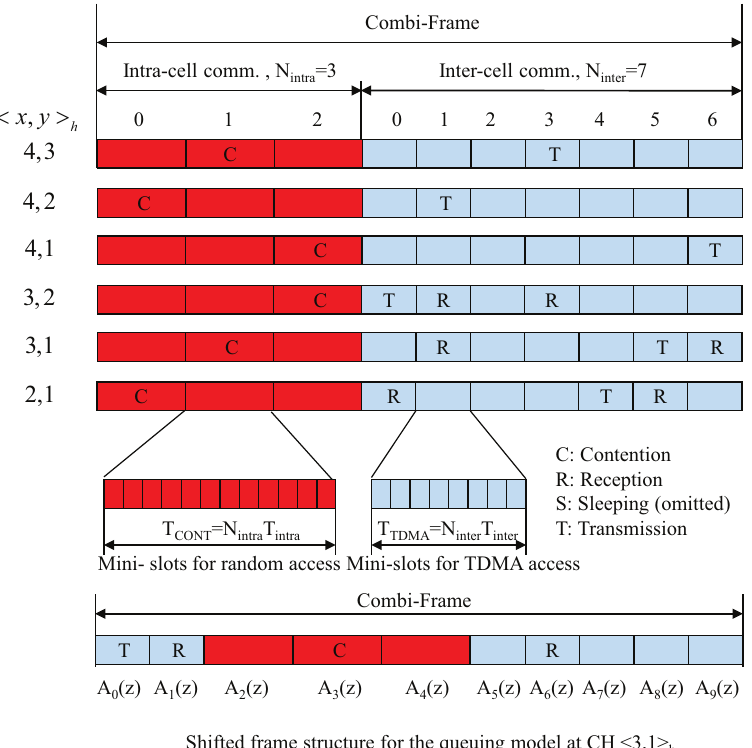
Figure 5. The role of A i ( z ) in several nodes located at S 0 when r max =